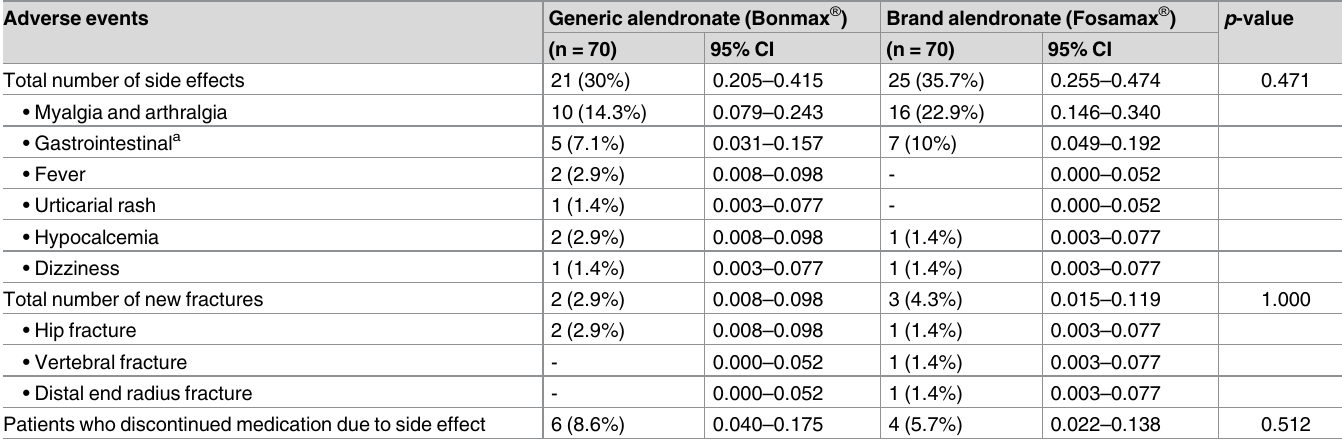
Table 4. Type and frequency of observed adverse